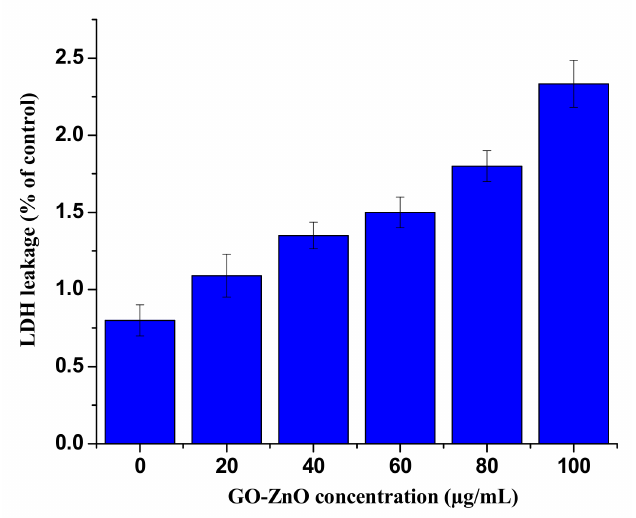
Figure 7. Lactate Dehydrogenase (LDH) release (%) in MCF-7 cells following incubation with GO-ZnO nanocomposites after 24 h. Treated groups exhibited the statistically significant differences from the control group, as measured by the Student’s t -test ( p <